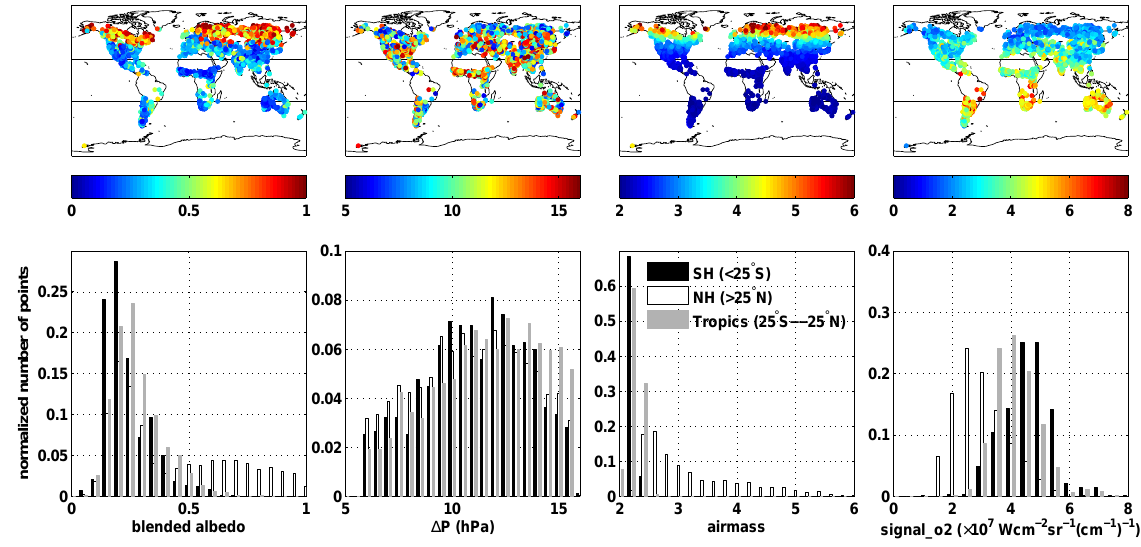
Fig. 9. A map and histogram of the parameters used in Eq. (4) in February. The horizontal black lines on the maps denote the 25° N and 25° S